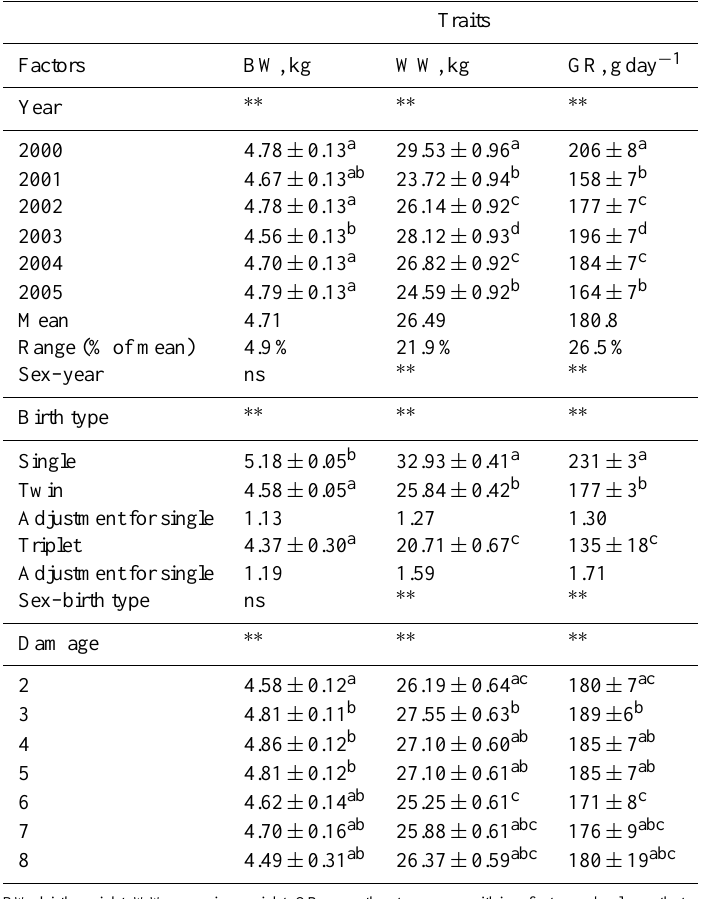
Table 3. Least-squares means ± SE of growth traits in male Afshari lambs.